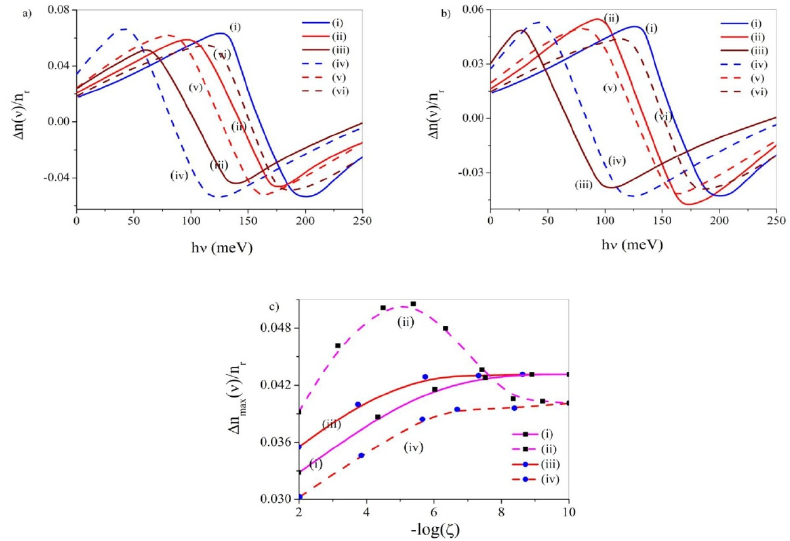
Figure 4. TORIC vs. h υ diagrams with ( a ) OPA and ( b ) EPA. In these diagrams (i) ADWN and ζ = 10 − 10 , (ii) ADWN and ζ = 10 − 6 , (iii) ADWN and ζ = 10 − 2 , (iv) MLWN and ζ = 10 − 10 , (v) MLWN and ζ = 10 − 6 , (vi) MLWN and ζ = 10 − 2 . ( c ) Depiction of TOAC peak heights vs. − log( ζ ): (i) with ADWN and OPA, (ii) with ADWN and EPA, (iii) with MLWN and OPA and (iv) with MLWN and EPA.